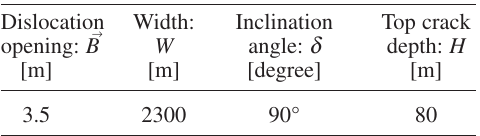
Table I. Parameters of the analysed dike. This geom- etry is the one of the analytical models obtained by Bonaccorso et al. (2002) to model ground deforma- tion changes recorded by permanent geodetic net- works during the dike emplacement of the Etna 2001